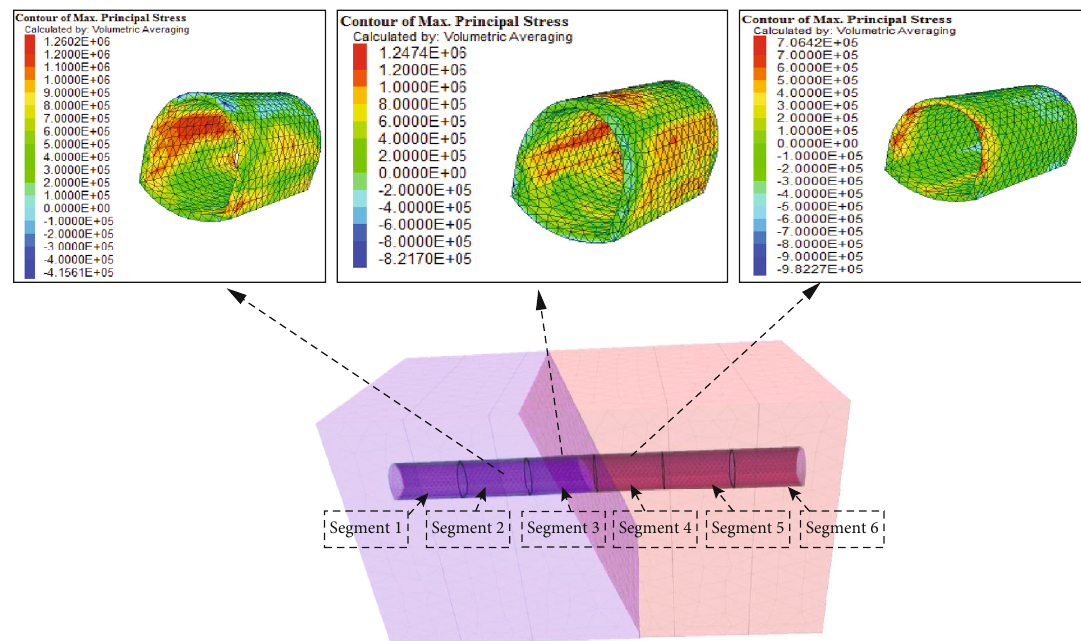
Figure 5: Maximum principal stress nephogram (units: Pa).